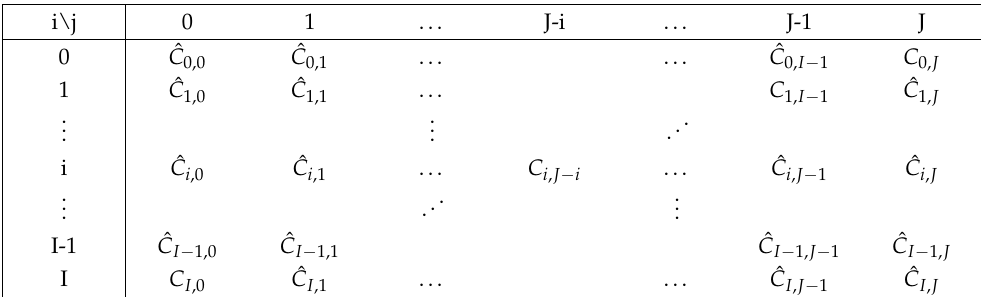
Table 3. Estimated upper triangle